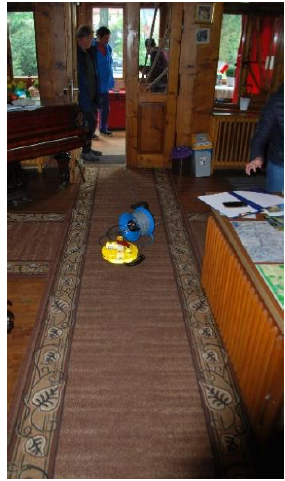
Figure 8. Measurement discs located in the hall of “Stara Polana” [30].